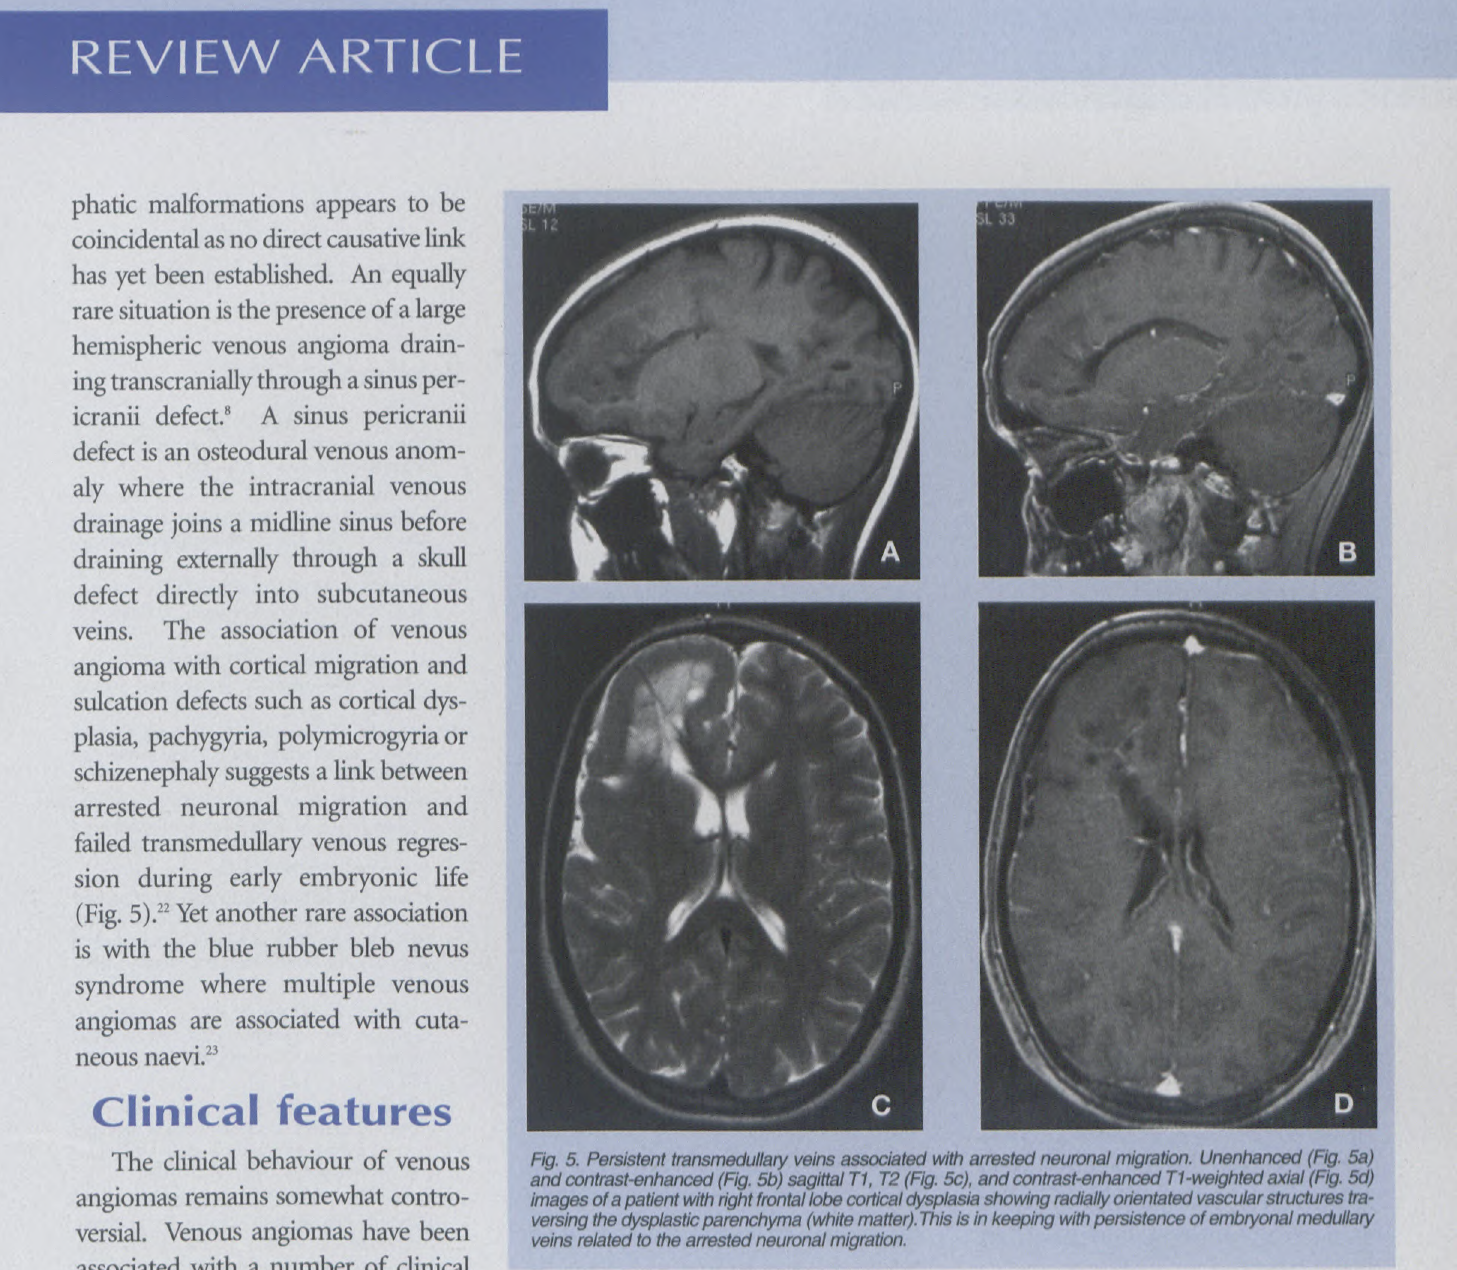
Fig. 5. Persistent transmedul/ary veins associated with arrested neuronal migration. Unenhanced (Fig. 58) and contrast-enhanced (Fig. 5b) sagittal T1, T2 (Fig. Sc), and contrast-enhanced T1-weighted axial (Fig. 5d) images of a patient with right frontal lobe cortical dysplasia showing radially orientated vascular structures tra- versing the dysplastic parenchyma (white matter). This is in keeping with persistence of embryonal medullary veins related to the arrested neuronal